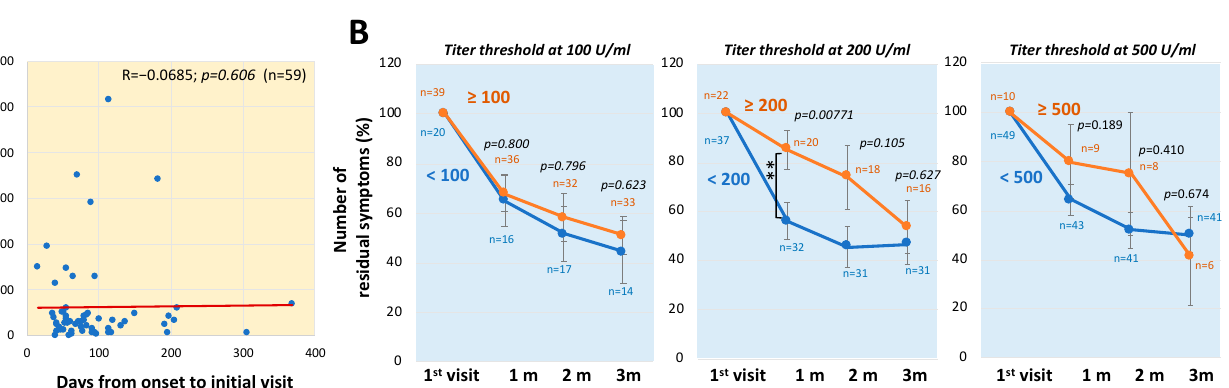
Figure 6. Serial changes in the number of residual symptoms during the three-month period after the initial visit according to antibody titers. ( A ) Interrelationship between serum antibody levels and duration from disease onset to initial visit. Spearman’s rank correlation coefficient was used for statistical analysis. ( B ) Changes in the numbers of residual symptoms of long COVID during the three-month period were compared between two groups based on the titers of anti-SARS-CoV-2 antibody in the patients’ sera. The data are shown as means ± SEM and were analyzed by the Mann-Whitney U test: ** p < 0.01, statistically significant between the indicated factors (“ n ” indicates the number of patients).